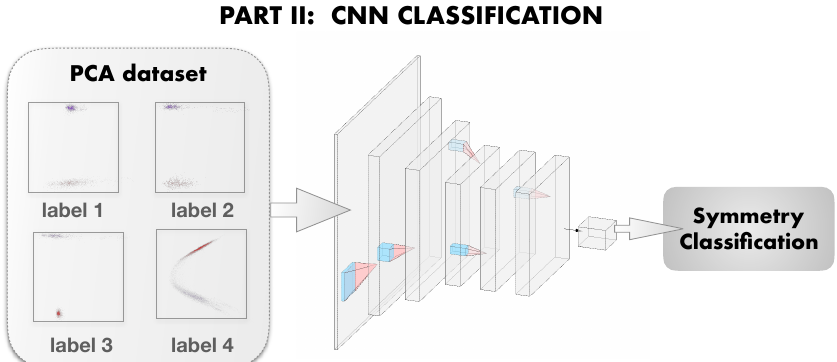
Figure 3: Part II: CNN Classification. The PCAs collected in Part I and labelled are used to train an algorithm to classify